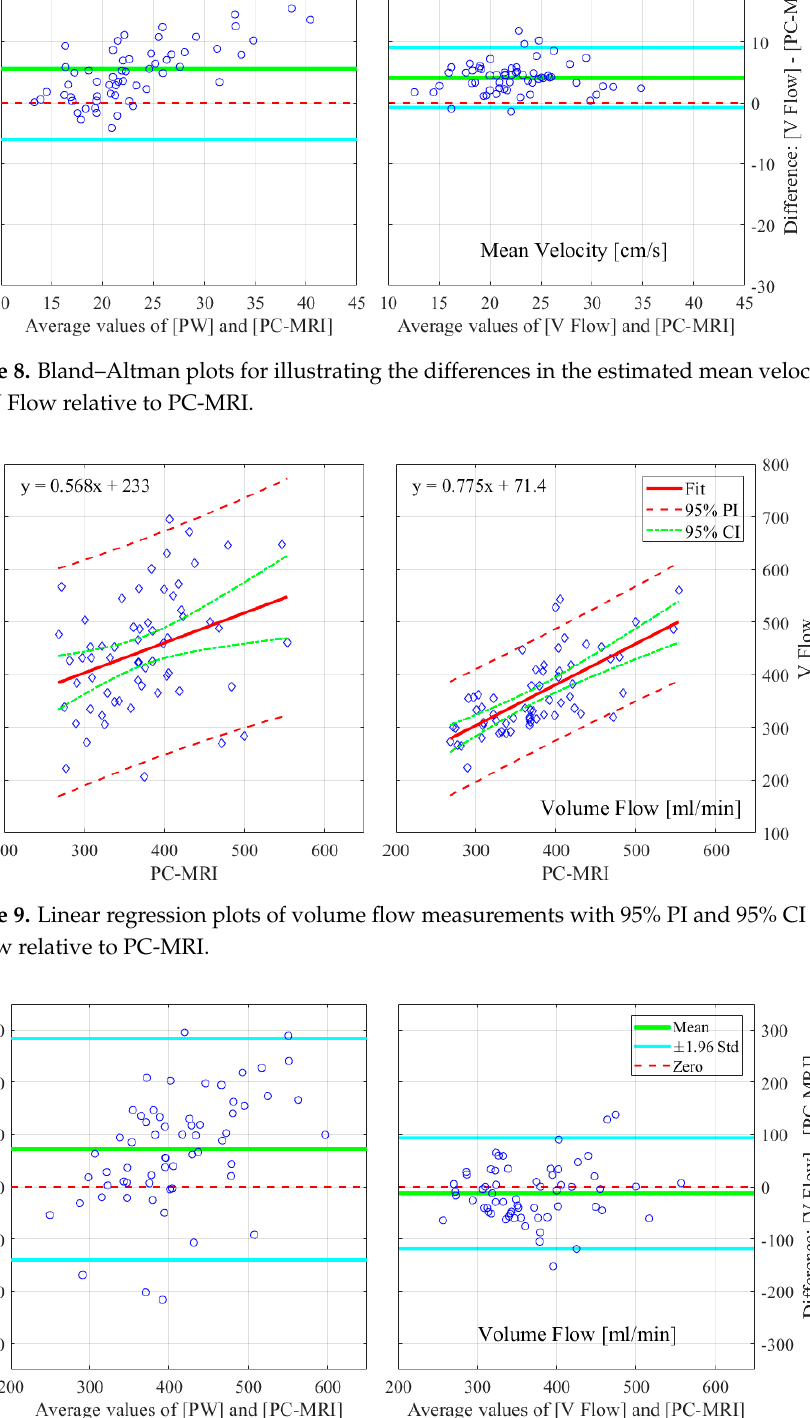
Figure 10. Bland–Altman plots for illustrating the differences in the estimated volume flow for PW and V Flow relative to PC-MRI.